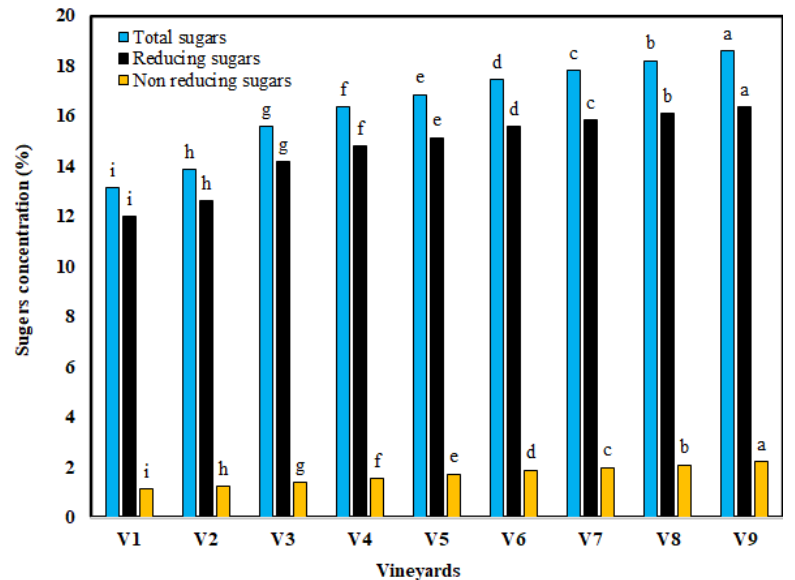
Figure 3. Distribution of mean values of total sugars, reducing sugars, and non-reducing sugars of Flame Seedless grape berries cultivated under various agronomical management and other practices in investigated vineyards. (Different letters indicate that the means are significantly different from each other ( p < 0.05)).